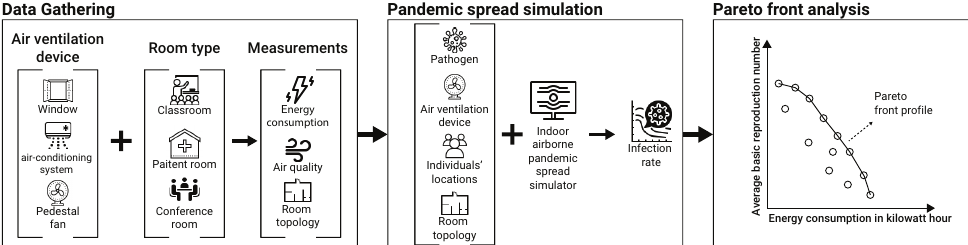
Figure 1. A schematic view of the research’s design, divided into data gathering, pandemic spread simulation, and epidemiological-energy Pareto front analysis. During the data gathering phase, we used several air quality and ventilation measurements alongside energy consumption to collect the required data for the pandemic spread analysis. Using the collected data, we estimate the average pandemic spread reduction using each ventilation solution via simulation. Finally, we perform a Pareto front analysis to study the trade-off between pandemic control and energy consumption and identify possible inefficient